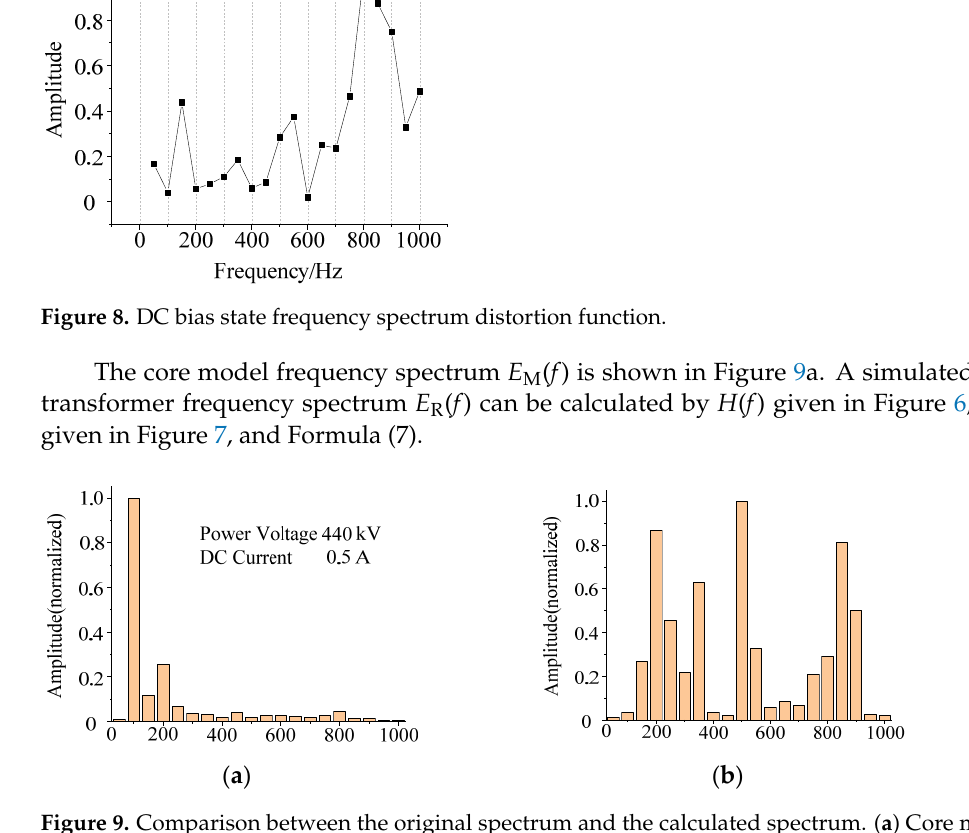
Table 2. Comparison of acoustic parameters calculation results.